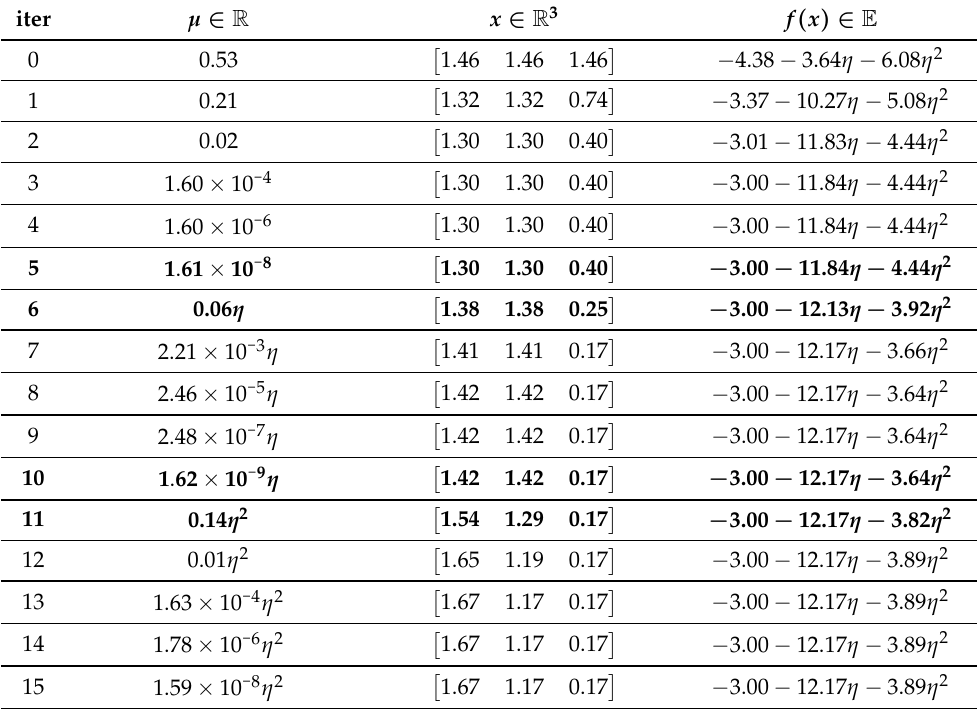
Table 4. Iterations of the NA-IPM solving the problem in (28).